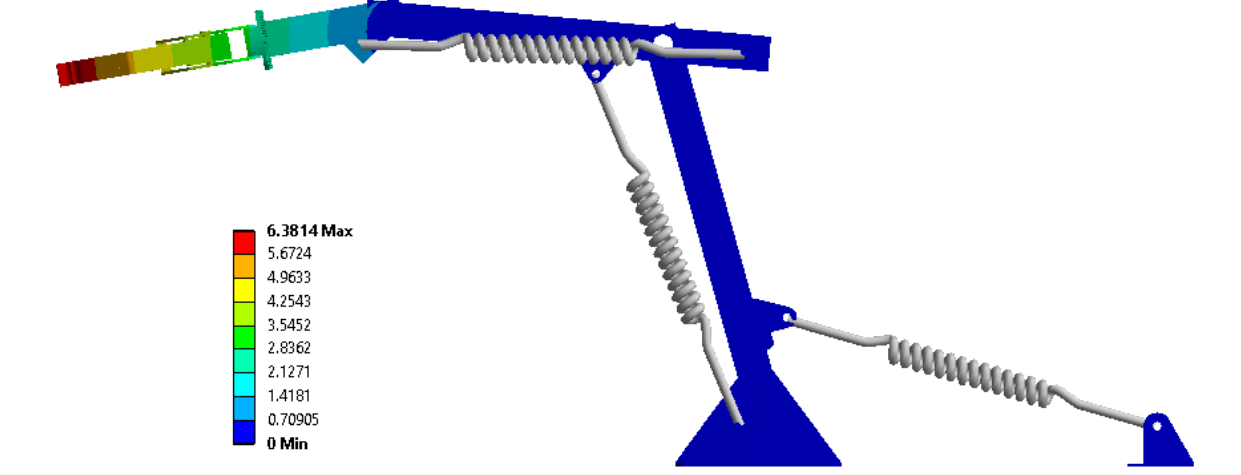
Figure 16. The resulting displacement field for configuration 3 and a force of 15 N.